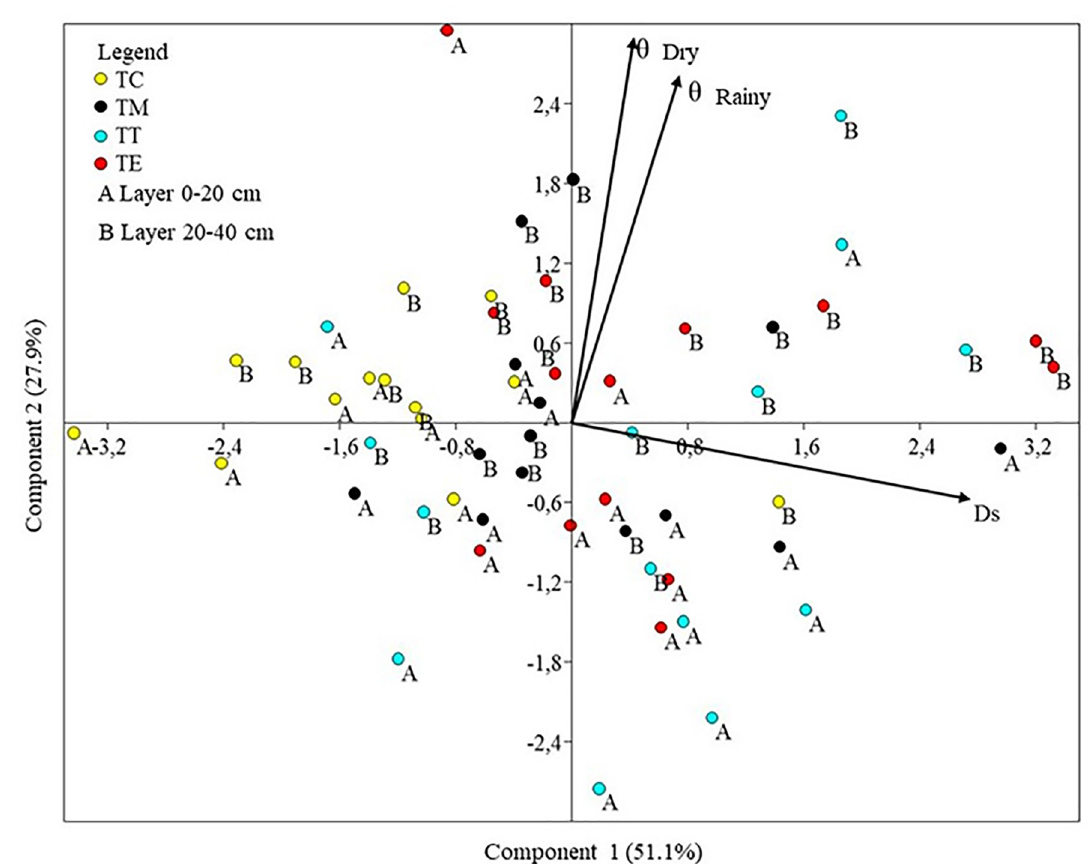
Fig 2. Principal component analysis (PCA) diagram of the physical variables. Ds = density; θ dry = volumetric humidity in the dry season; θ rainy = volumetric humidity in the rainy season; TC = samples taken from the soil under the Cerrado; TM = substrate samples taken from pits where seedlings did not survive; TT = substrate samples taken from T . guianensis pits; TE = substrate samples taken from C . pachystachya pits.